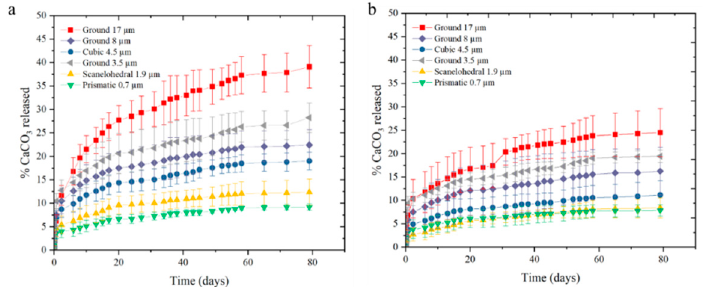
Figure 7. Release of CaCO 3 from the implant geometry as a function of time for the injection-molded ( a ) and extruded ( b ) samples. The insert shows the burst rate kinetics of CaCO 3 within the first 2.5 h . Error bars indicate ±1 standard deviation for 3 sample repetitions, and the data point is the average value.